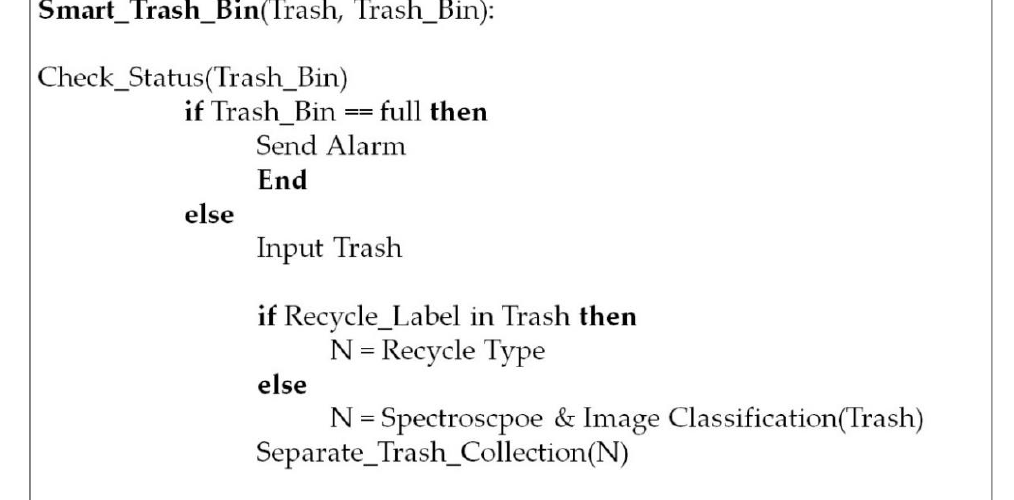
Figure 4. Pseudocode of the Smart Trash Bin.